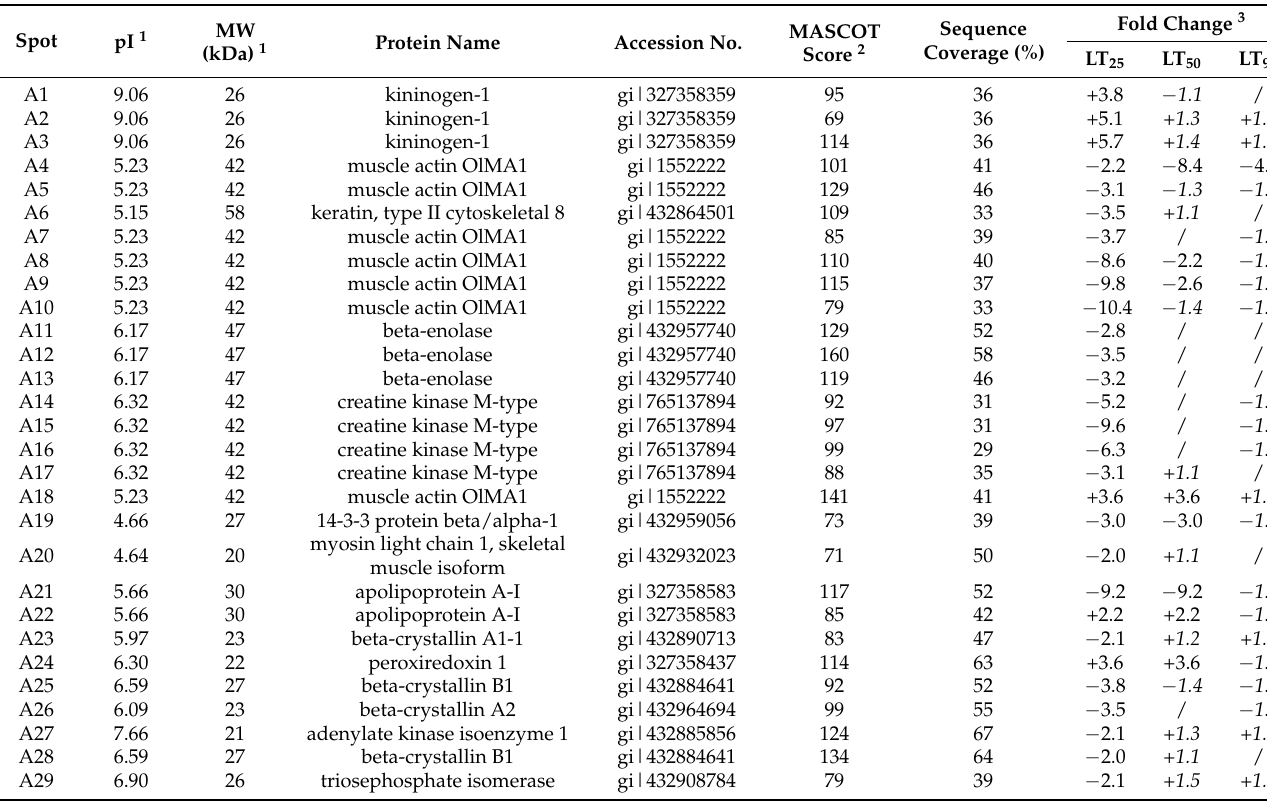
Table 1. Differential protein spots (A1–A29) with at least two-fold differences in 2-DE images of Karenia -exposed medaka collected at LT 25 compared with untreated medaka and their expression levels relative to the control at different expo- sure times.